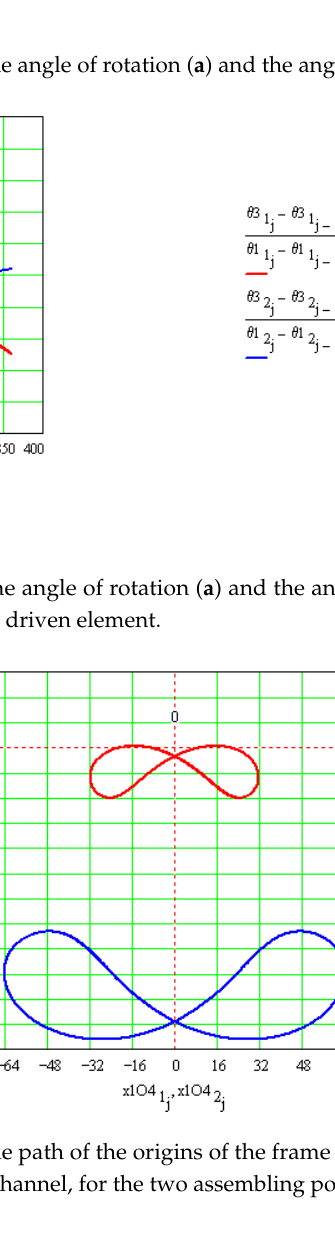
( b ) Figure 21. The angle of rotation ( a ) and the angular velocity of the axis of centers in the middle plane of the channel ( b ). ( a ) ( b ) Figure 22. The angle of basculation ( a ) and the corresponding angular velocity ( b ) of the intermedi- ate element with respect to the axis of centers.